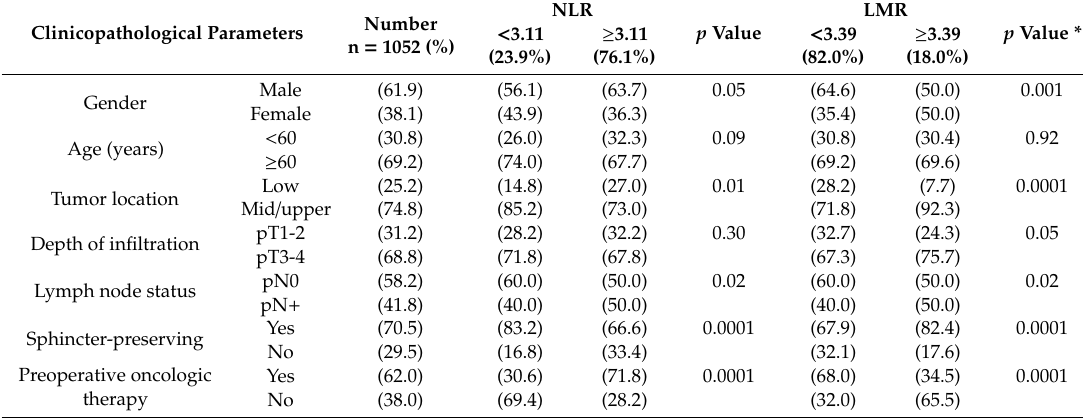
Table 1. Correlation between clinicopathological factors and serum indicators of systemic inflammatory